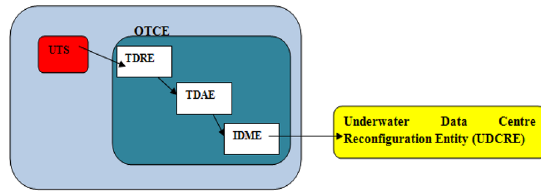
Figure 1. Relation between the UTS, OTCE and